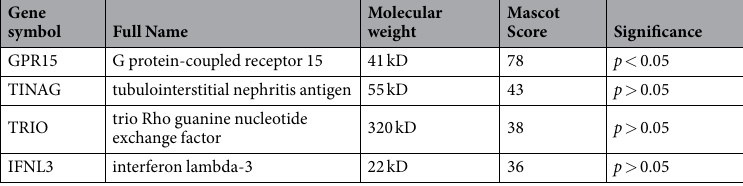
which was mediated by the activation of extracellular signal-regulated kinase (ERK) signal transduction path- way 9 . Further experiments identified the fifth EGF-like region of TM (TME5) exerts endothelial cytoprotective functions of rTM via APC-independent manner 10 . TM also possesses pro-angiogenic activity via its EGF-like domain 9 . The present study aimed to identify the cell surface expressed protein that interacts with TME5 and mediates endothelial cytoprotective as well as pro-angiogenic function of rTM.